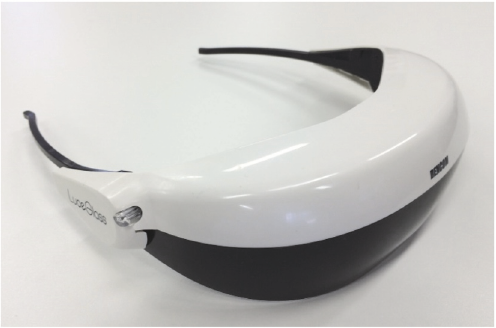
Figure 1: Goggles for bright light therapy. LEDs at the back of the frame are used as the light source.